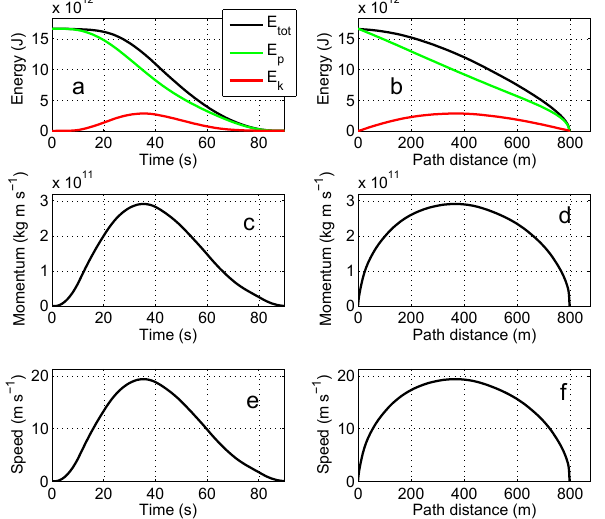
Figure 6. Total energy (black), potential energy (green) and kinetic energy (red) as (a) a function of the time and (b) a function of the travelled distance. Momentum of the centre-of-mass as (c) a func- tion of the time and (d) a function of travelled distance. Speed of the centre-of-mass as (e) a function of the time and (f) a function of the travelled